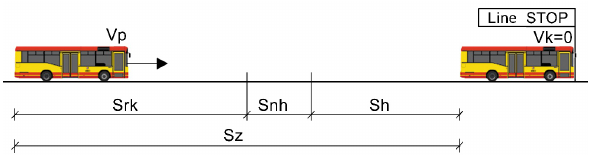
Figure 1: Diagram of the stopping path of a bus S Z in front of